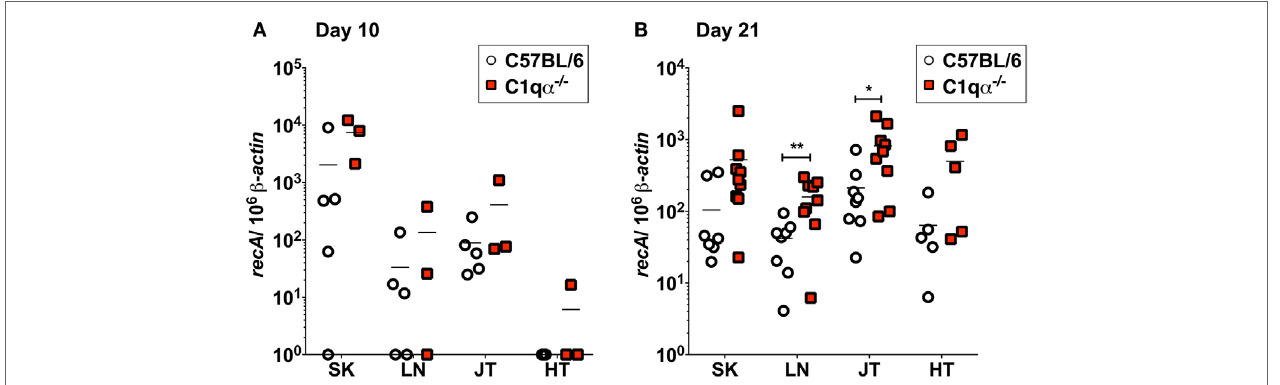
FigUre 3 | Bacterial load of Borrelia burgdorferi in C57BL/6 and C1q α − / − mice. Quantitative PCR (qPCR) from mice infected with 10 4 B. burgdorferi strain (ML23/ pBBE22 luc) following 10 days (a) or 21 days (B) . White circles and red squares indicate the data points from samples of C57BL/6 and C1q α − / − knockout mice, respectively [ n = 3–4 for panel (a) ; n = 9 for panel (B) ]. Abbreviations: SK, skin; LN, lymph node; JT, joints; HT, heart. The results are represented as the number of borrelial genome copies per 10 6 mouse β -actin copies (* P < 0.05 and ** P <